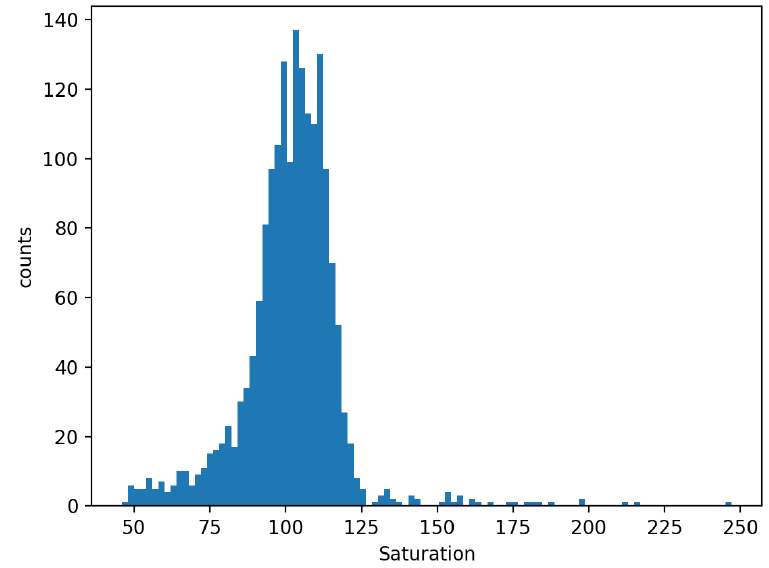
Figure 4. Distribution of saturation in a sample image.